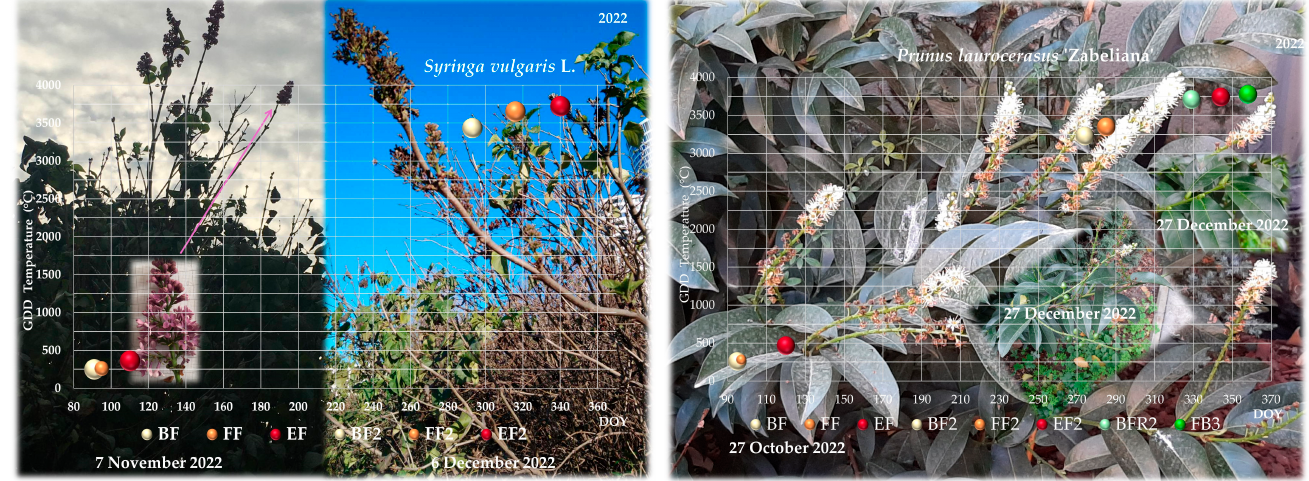
Figure 10. Phenological observations: GDD and DOY for the beginning of first flowering (BF), full first flowering (FF), the end of first flowering (EF), beginning of second flowering (BF2), full second flowering (FF2), the end of second flowering (EF2), BFR2 (beginning of second fruit set), and flower bud set (FB3) for Common Lilac (left) and Zabel’s Laurel (right) in 2022.